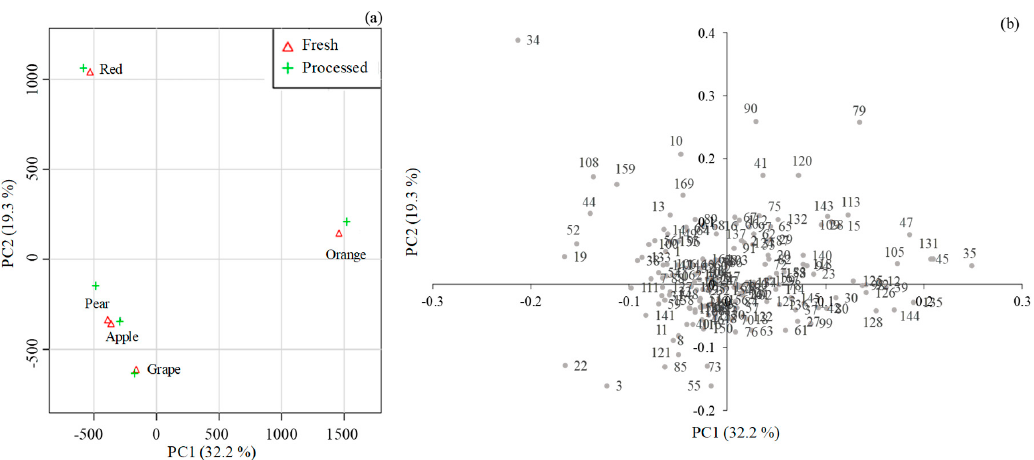
Figure 3. Principal component analysis (PCA) of the volatile signature of fresh and processed fruit juices. ( a ) PC1 × PC2 score scatter plot and ( b ) loading weight plot (attribution of the peak number is shown in Table S1).